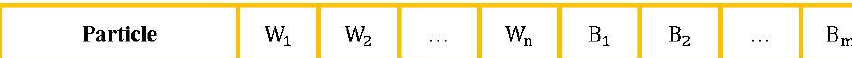
Figure 6. Particle definition in the NSBPSO algorithm.